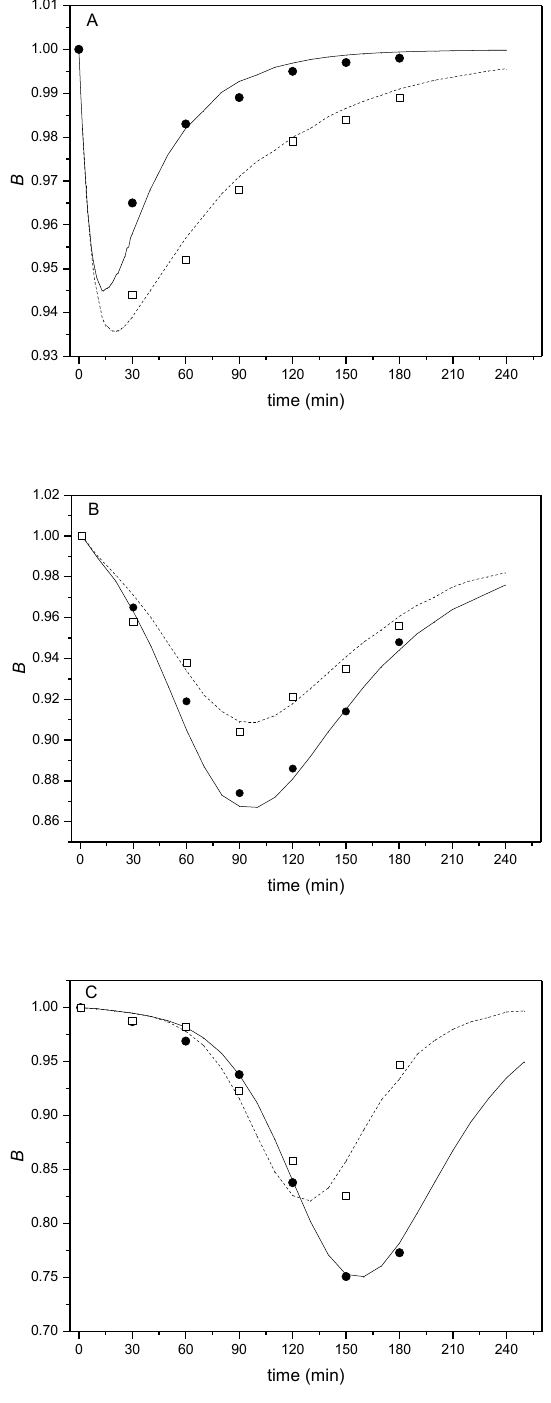
Figure 2. Theoretical shape of the B ( t ) curves (solid line for BALB/c, dashed line for C57BL/6Nvel) obtained by integration of kinetic equations (details in Appendix A in Supplementary Materials) for the selected dilution D , molar ratio n , and optimized values of K 2 and K 3 (Table 2) with designation of the points obtained in the experiment (solid circles for the BALB/c experiments, and solid squares for the C57BL/6Nvel experiments) for estradiol concentrations; ( A ) 200 µ g/L, ( B ) 20 µ g/L, and ( C ) 2 µ